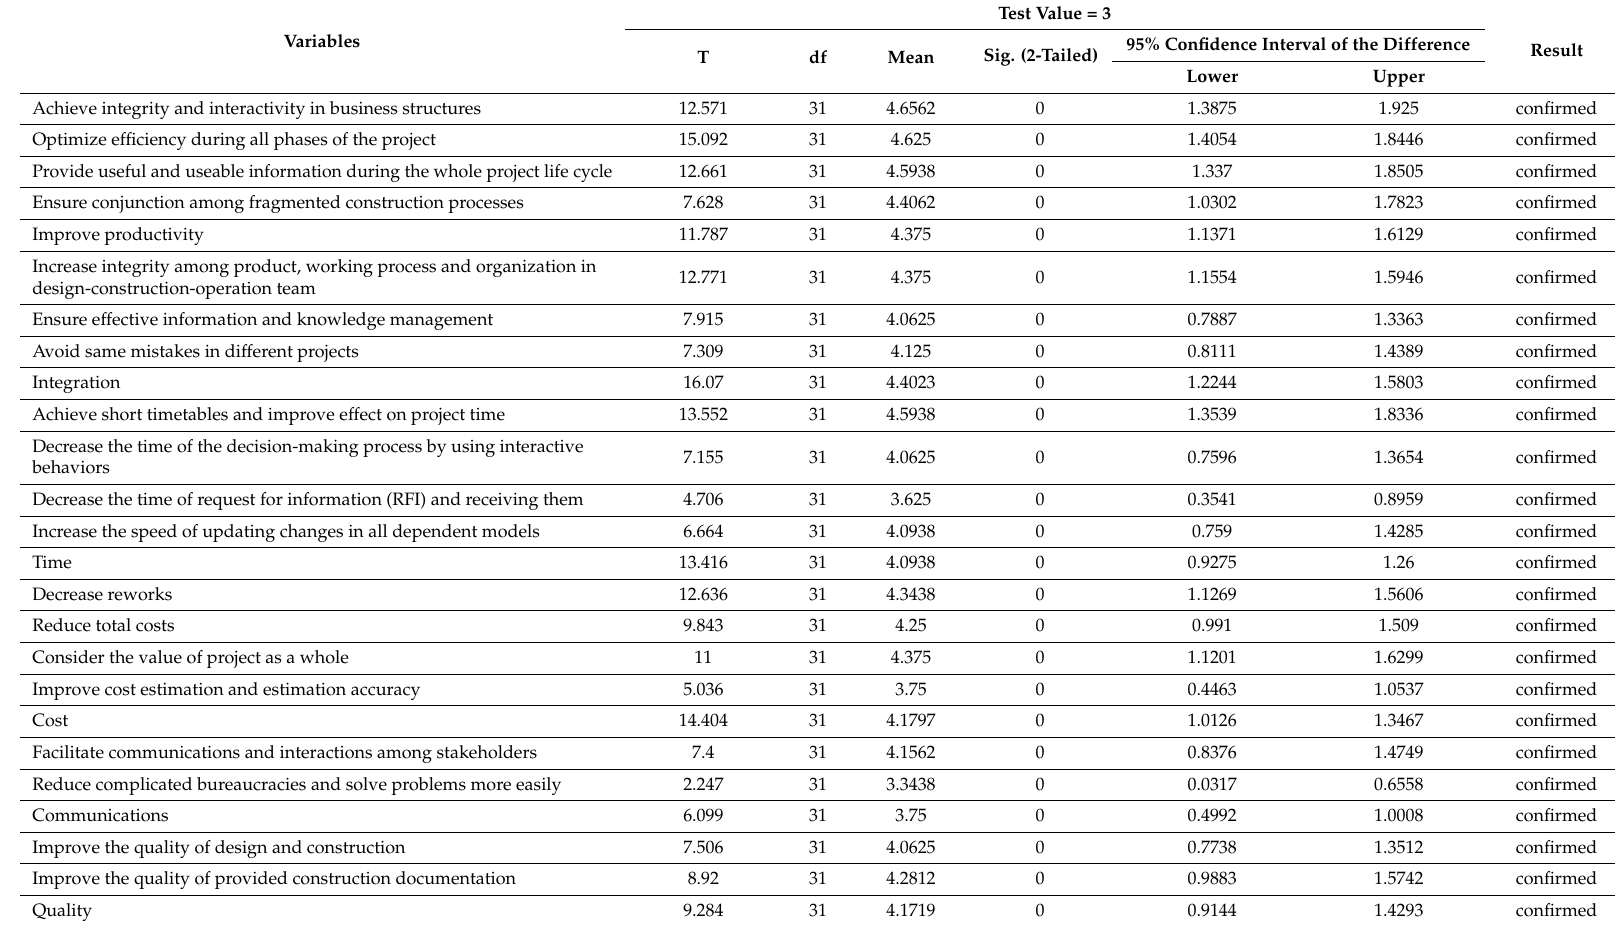
Table 6. Results of one-sample T-test for the evaluation of